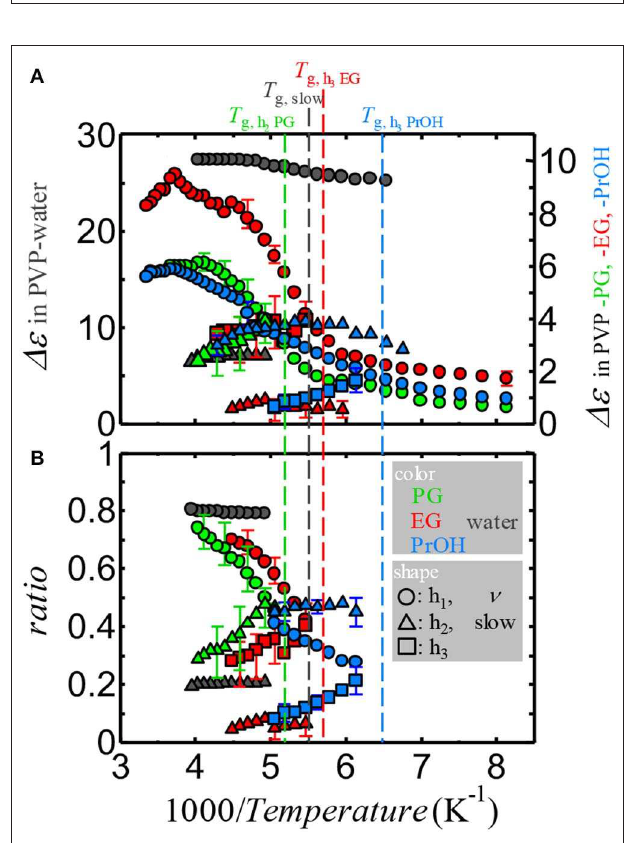
FIGURE 5 | The corresponding DSC thermograms are also shown above each panel, with the gray ranges indicating the possible glass transition temperatures. Gray plots indicate the relaxation time of pure solvents [56–58]. Error bars indicate uncertainty of the fitting procedures. Plots without error bar have errors within the plot size. Multiple plots for the PVP–water mixture indicate measurements with different electrodes to characterize the additional small process.